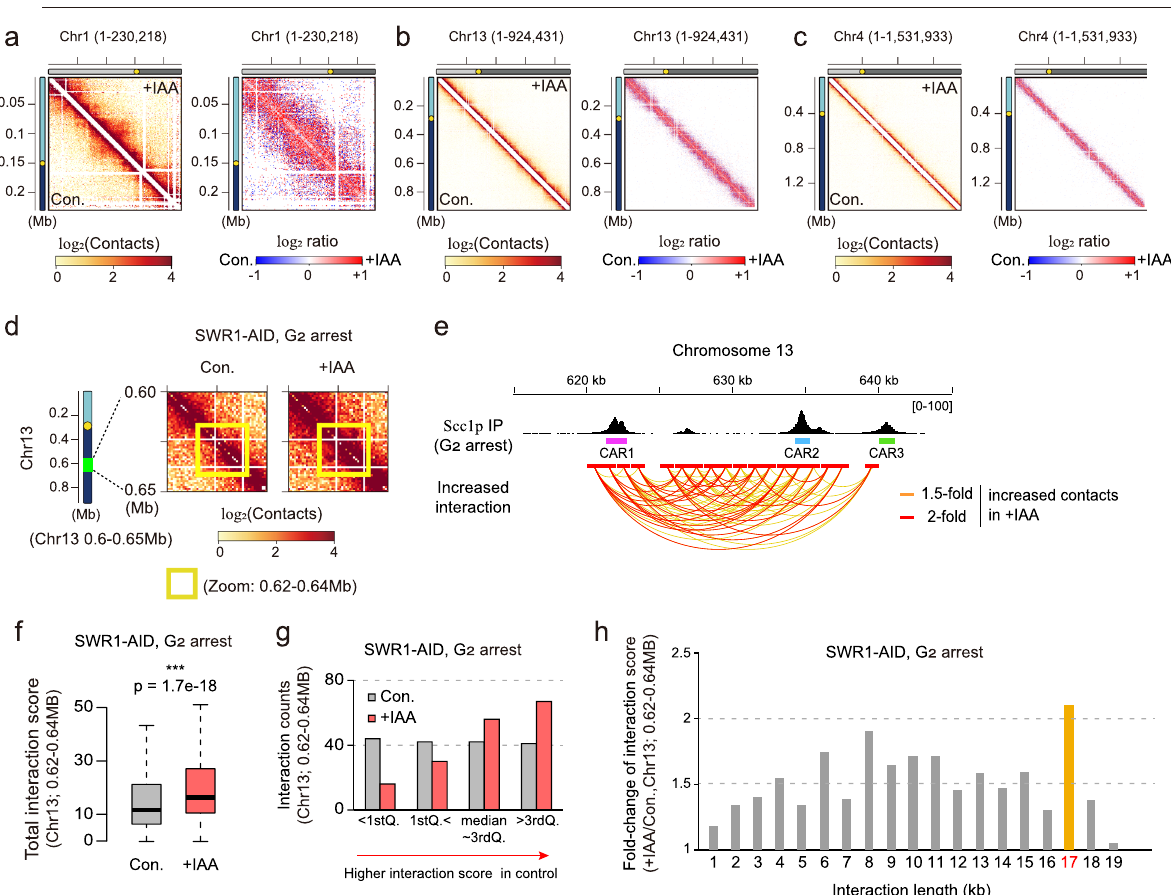
Fig. 3 Swr1p modulates 3D genome organization in a manner that depends on the chromosomal context and/or cell cycle stage. a – c Contact maps (1- kb resolution) of chromosome 1, 13, and 4, respectively, for SWR1-AID strain arrested at G 2 phase. The left panel shows the ICE-normalized matrix and the right panel shows the log 2 ratio matrix of contact maps for knockdown versus control samples for each chromosome. d Zoom-in log 2 ratio-interaction map of chromosome 13 (0.6 – 0.65 Mb region) for SWR1-AID strain at G 2 phase. Schematic representations including genomic distances and position are displayed on the left side of d . The yellow dots indicate the point centromere of the chromosome. The yellow box highlights a locus within 0.62 – 0.64 Mb. e (top) IGV data visualizing the localization of Scc1p on chromosome 13 under nocodazole-induced G2/M arrest. Pink, cyan, and yellow-green boxes indicate the Scc1p peak loci called the cohesin-associated region (CAR). Data deposited under accession number GSM4577764 was used for data analysis. (bottom) Arc plot displaying intra-chromosomal interactions within the 0.62 – 0.64 Mb region of chromosome 13. The red lines highlight contacts that showed >2-fold higher contact scores in + IAA samples compared to control samples, while orange lines highlight contacts that showed >1.5-fold higher contact scores in + IAA samples. f Boxplot comparing the interaction score of intra-chromosomal interactions (n = 170) within the 0.62-0.64 Mb region of chromosome 13 between control and + IAA samples. The p-value was calculated by a one-sided Wilcoxon rank-sum test. (*** p -value < 0.001). Boxplot show median; box limits, upper and lower quartiles; whiskers. g The number of intra-chromosomal interactions within the 0.62 – 0.64 Mb region of chromosome 13 in control and + IAA samples. Total 168 contacts were divided into four groups (25%) by interaction score; (1) <1st Quantile, (2) >1st but <2nd Quantile (median), (3) >2nd but <3rd Quantile, and (4) >3rd Quantile. h The relative of intra-chromosomal interaction counts along the interaction distance within the 0.62 – 0.64 Mb region of chromosome